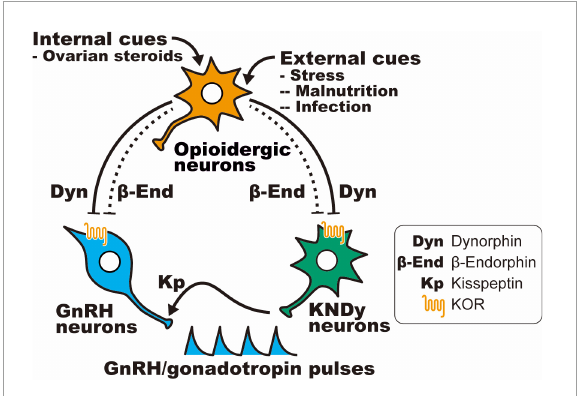
FIGURE3 Schematic illustration showing a current interpretation of the opioidergic pathway in the regulation of GnRH/gonadotropin release in mammals: hypothalamic dynorphin and β -endorphin neurons serve as mediators of the inhibitory effect of ovarian steroids (internal cues) and/or stressors (e.g., malnutrition and infection; external cues) on GnRH/gonadotropin release in female mammals. It is likely that dynorphin directly acts on the majority of KNDy and GnRH neurons via the KOR, whereas β -endorphin indirectly (dotted line) acts on KNDy and GnRH neurons via µ -opioid receptor (MOR)-expressing